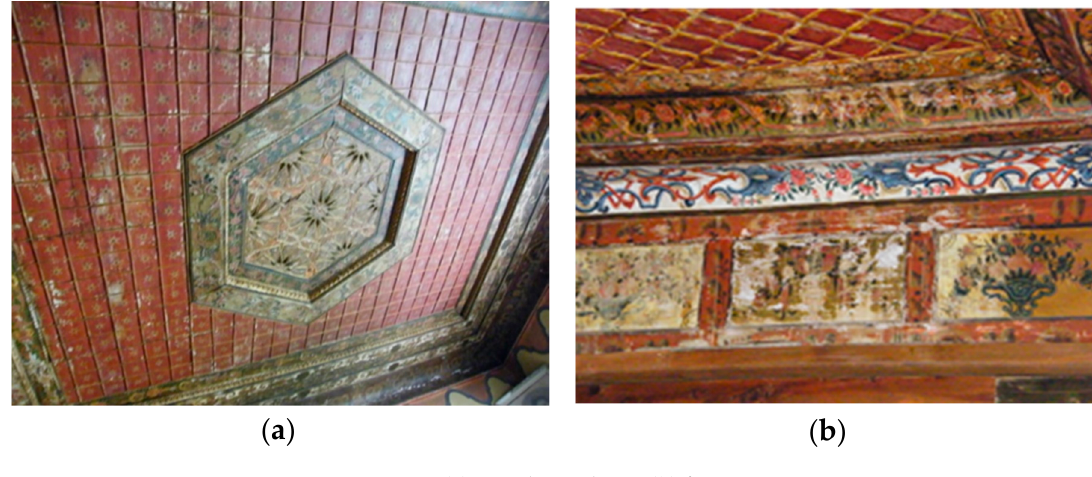
Figure 2. ( a ) Wooden ceilings, ( b ) frescos.